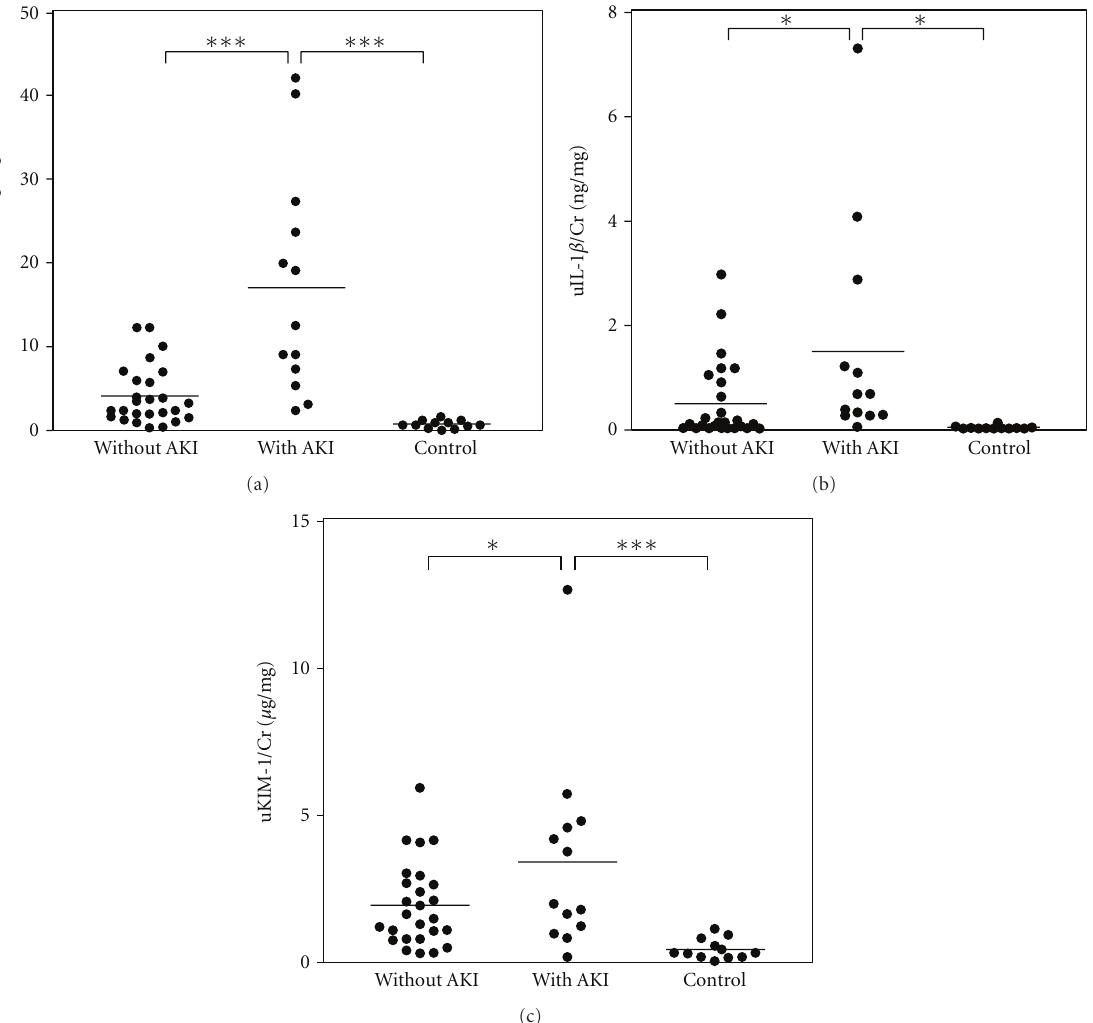
Figure 1: The urinary MIF level is markedly elevated in the presence of AKI in patients with kidney infections. The concentrations of MIF, IL-1 β , and KIM-1 in the urine were measured by ELISA and were normalized based on the urinary creatinine (Cr) levels. The urinary levels of MIF (uMIF/Cr) (a), IL-1 β (uIL-1 β /Cr) (b), and KIM-1(uKIM-1/Cr) (c) were measured in APN patients with ( n = 13) or without ( n = 26) AKI and in normal controls ( n = 12). Data are the means SD. ∗∗∗ P < 0 . 001, and ∗ P < 0 .